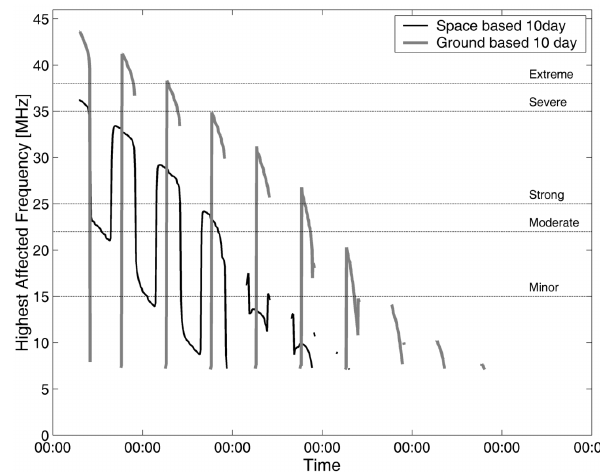
Fig. 12. The Highest Affected Frequency for the RBR-cases shown in Figs. 8 and 9, in the same format as the lower panel in Fig.